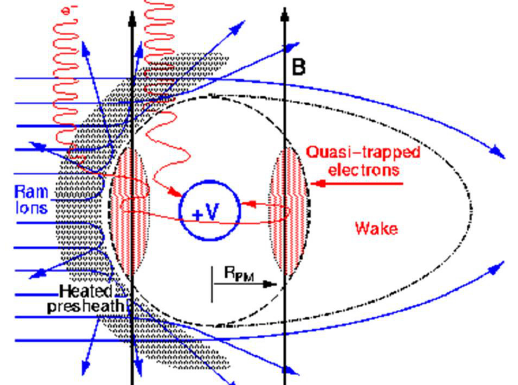
Figure 1. Schematic illustration of the interaction model [20].